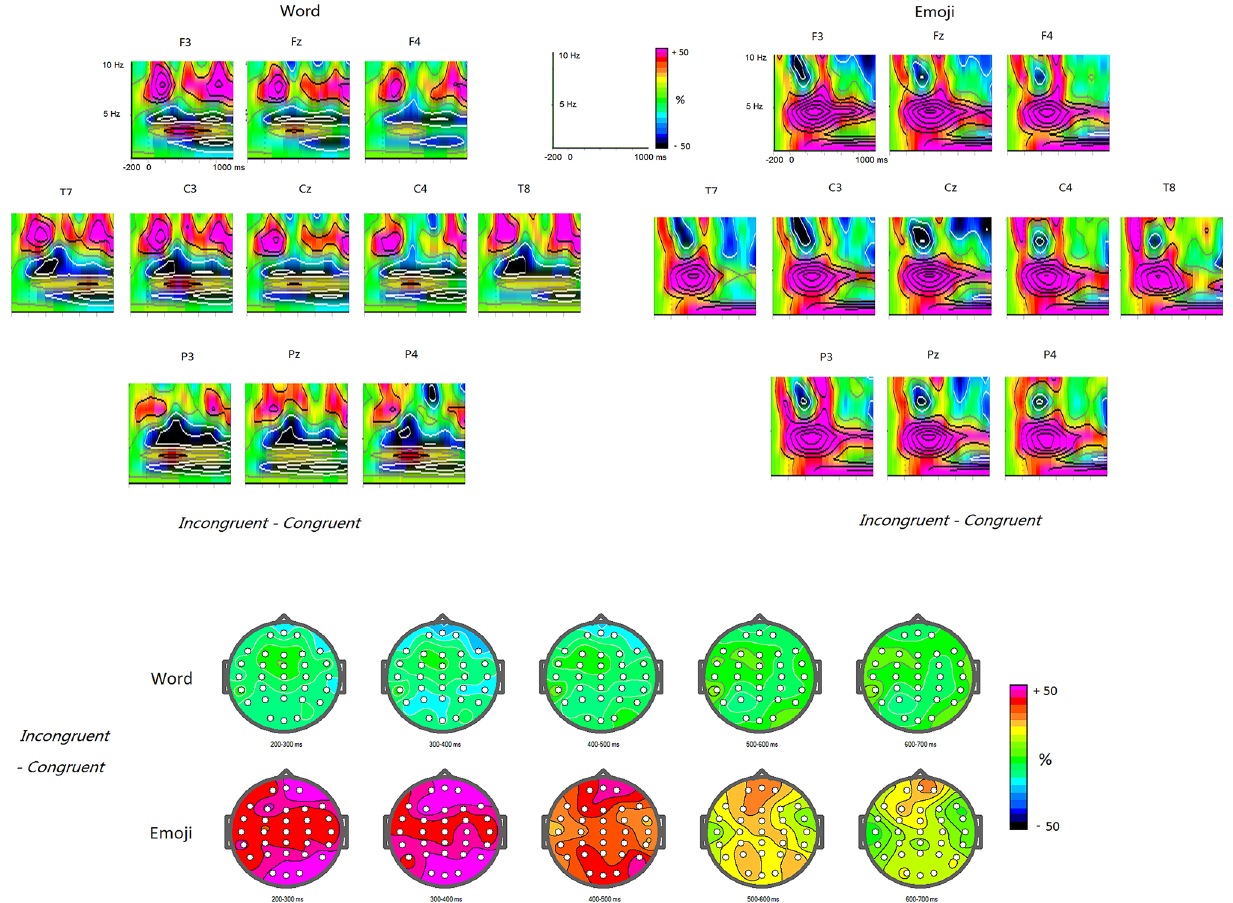
Figure 2. The differences of TBOs and ABOs between incongruent and congruent conditions for word and emoji conditions as well as the 2D scalp mapping,